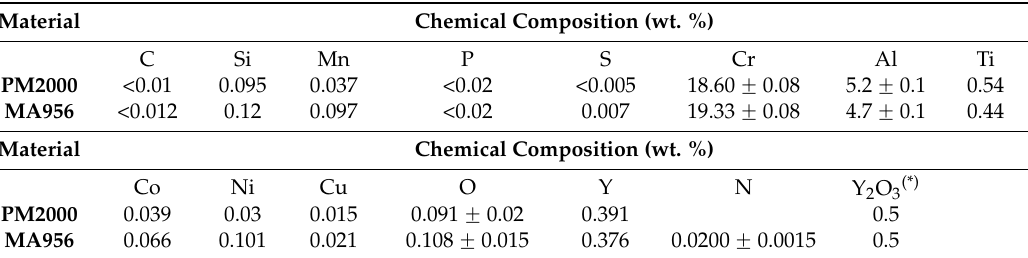
Table 1. Chemical composition of the PM2000 and MA956